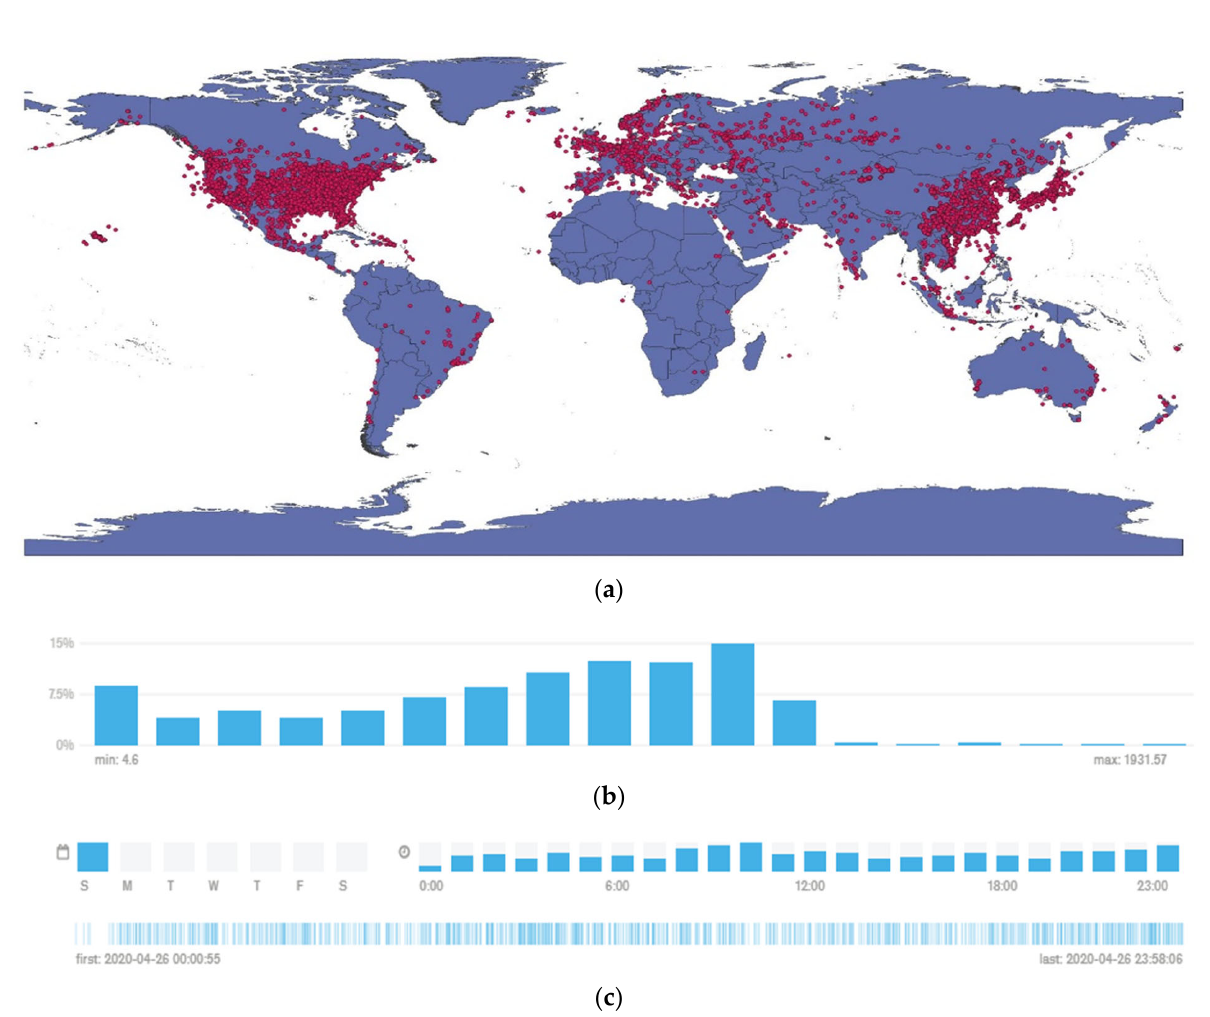
Figure 9. Geographical distribution of data: ( a ) the distribution of planar latitude and longitude; ( b ) height range distribution; ( c ) time range distribution.